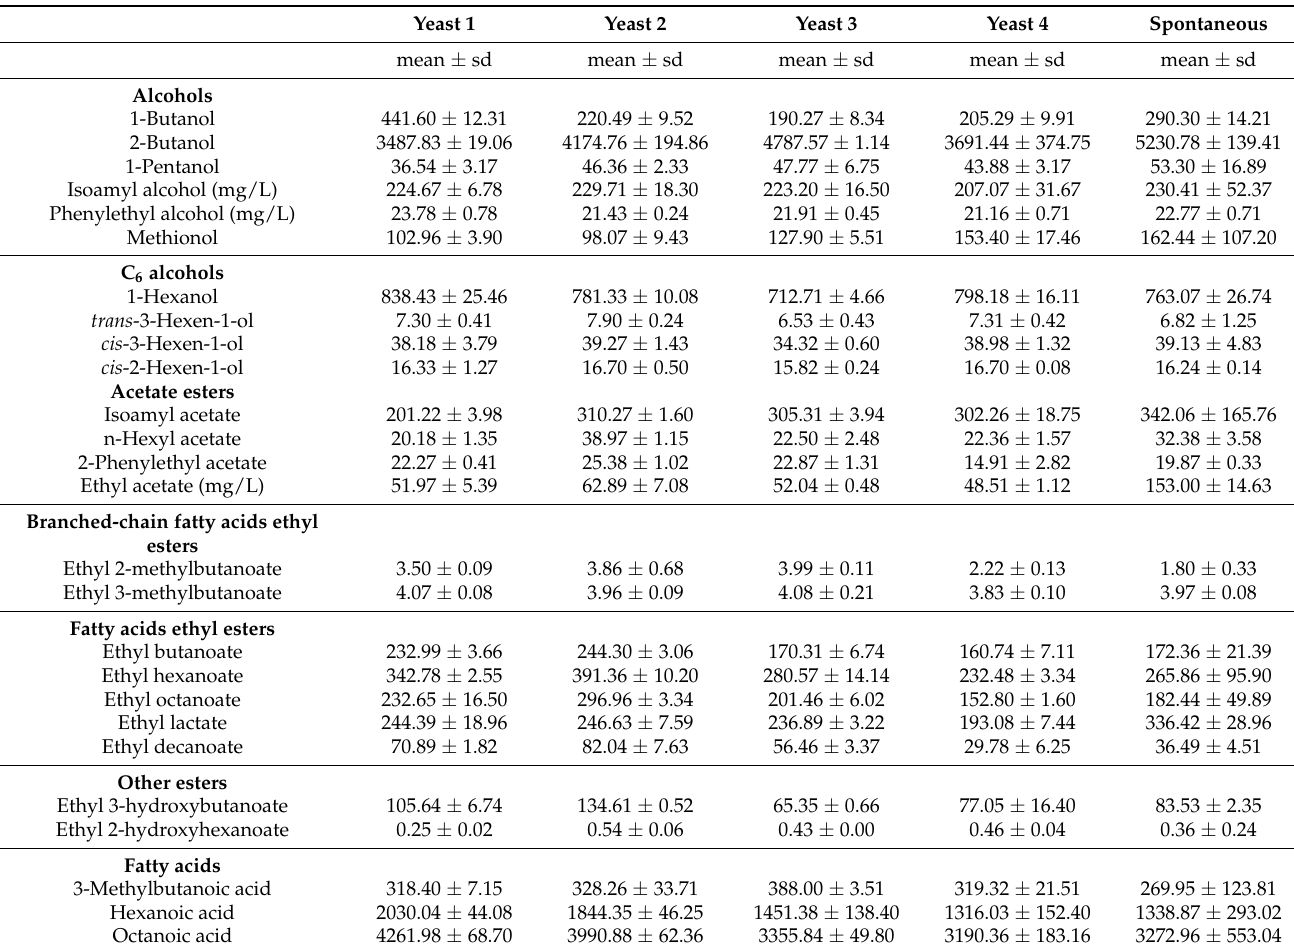
Table 4. Concentration ( µ g/L) and standard deviation ( ± µ g/L) of volatile compounds of Area 2 Corvina